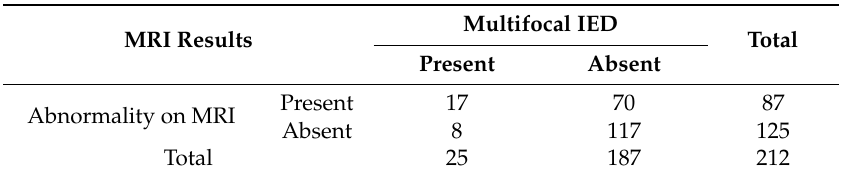
Table 3. Presence of abnormalities in magnetic resonance imaging (MRI) according to multifocal interictal epileptiform discharges (IED) ( p = 0.004). Multifocal IED MRI Results Total Present Absent Present 17 70 87 Abnormality on MRI Absent 8 117 125 Total 25 187 212